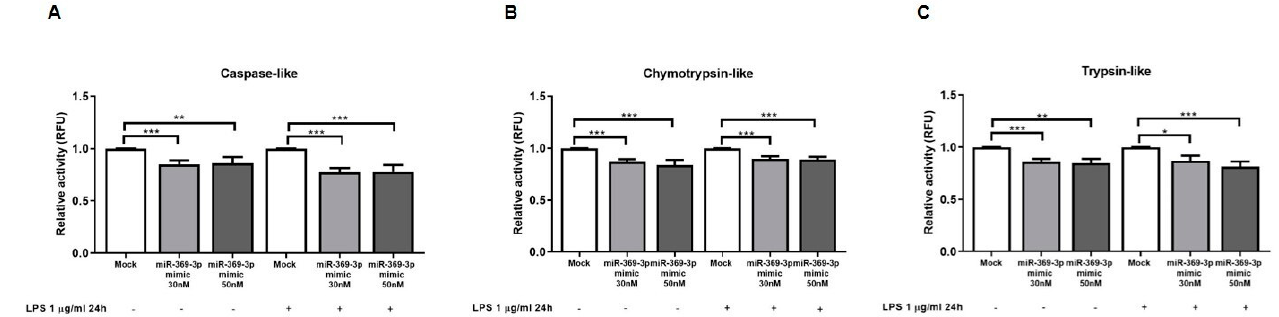
Figure 5. miR-369-3p reduced immunoproteasome activities. RAW264.7 cells transfected with miR-